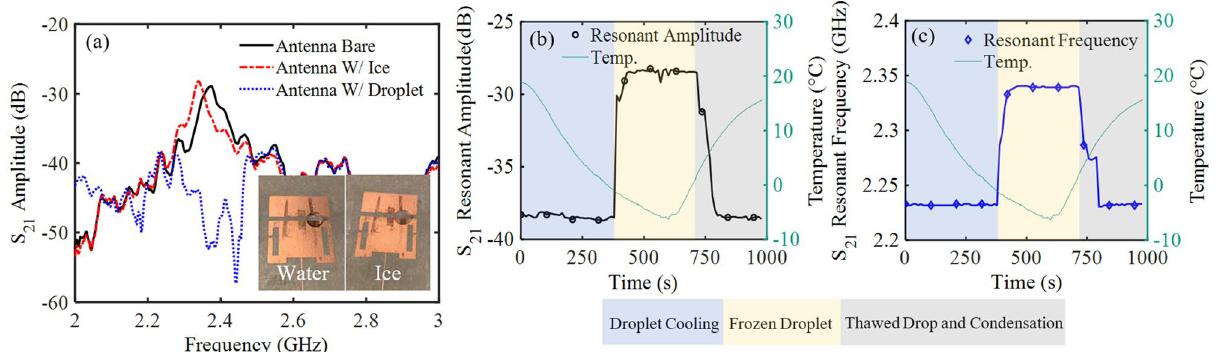
Figure 9. The S 21 response of the antenna while freezing a water droplet to the most sensitive region. The ( a ) spectrum response of the transmitted signal is displayed for the three key regions and the ( b ) resonant amplitude and ( c ) resonant frequency were tracked over time.